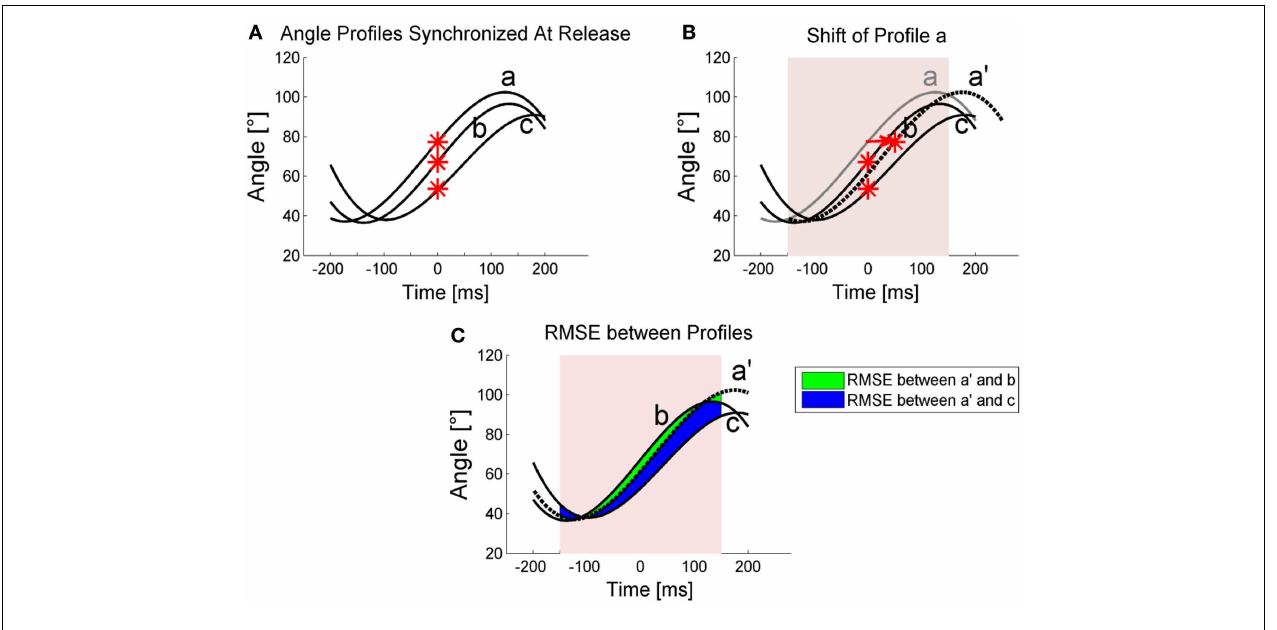
the following RMSE calculation were done for 300ms around release. (C) RMSE between trials. Note that for reasons of illustration, only areas between a (cid:48) and b as well as a (cid:48) and c for RMSE determination are displayed. RMSE between b and c was also calculated and all three RMSE determined total RMSE t .